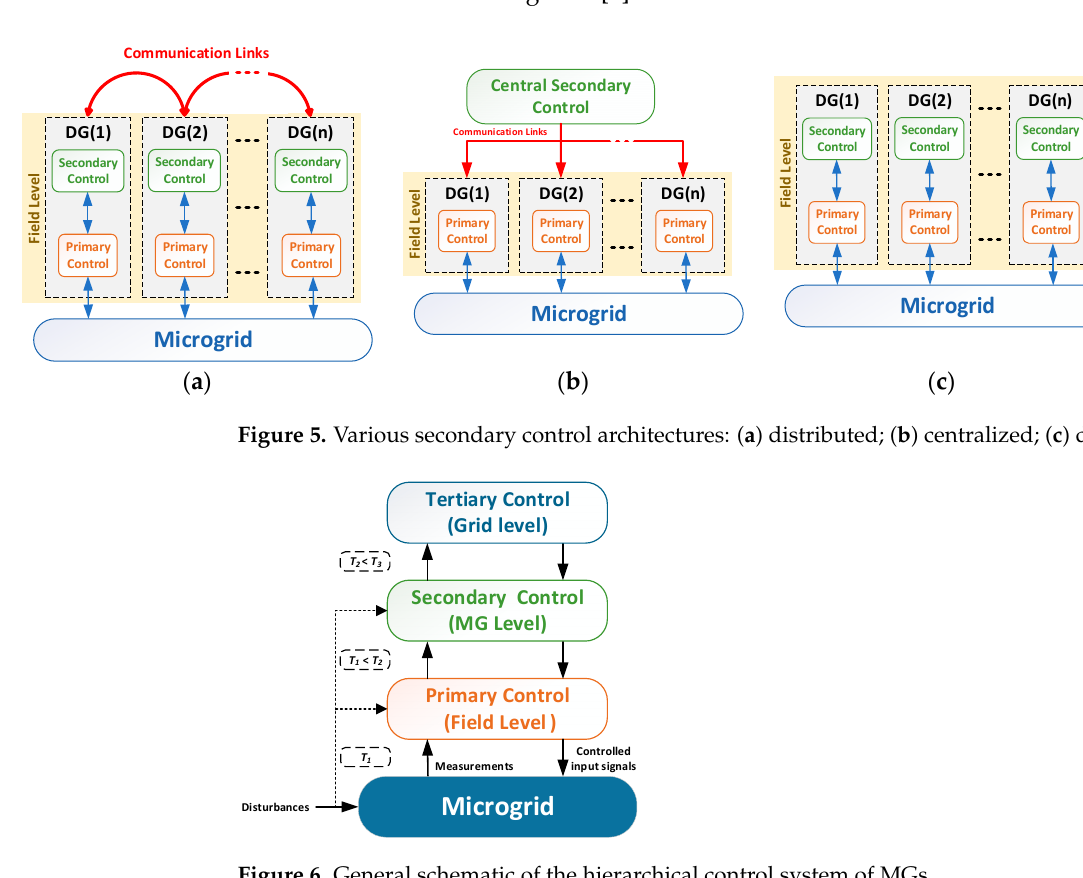
Figure 6. General schematic of the hierarchical control system of MGs.